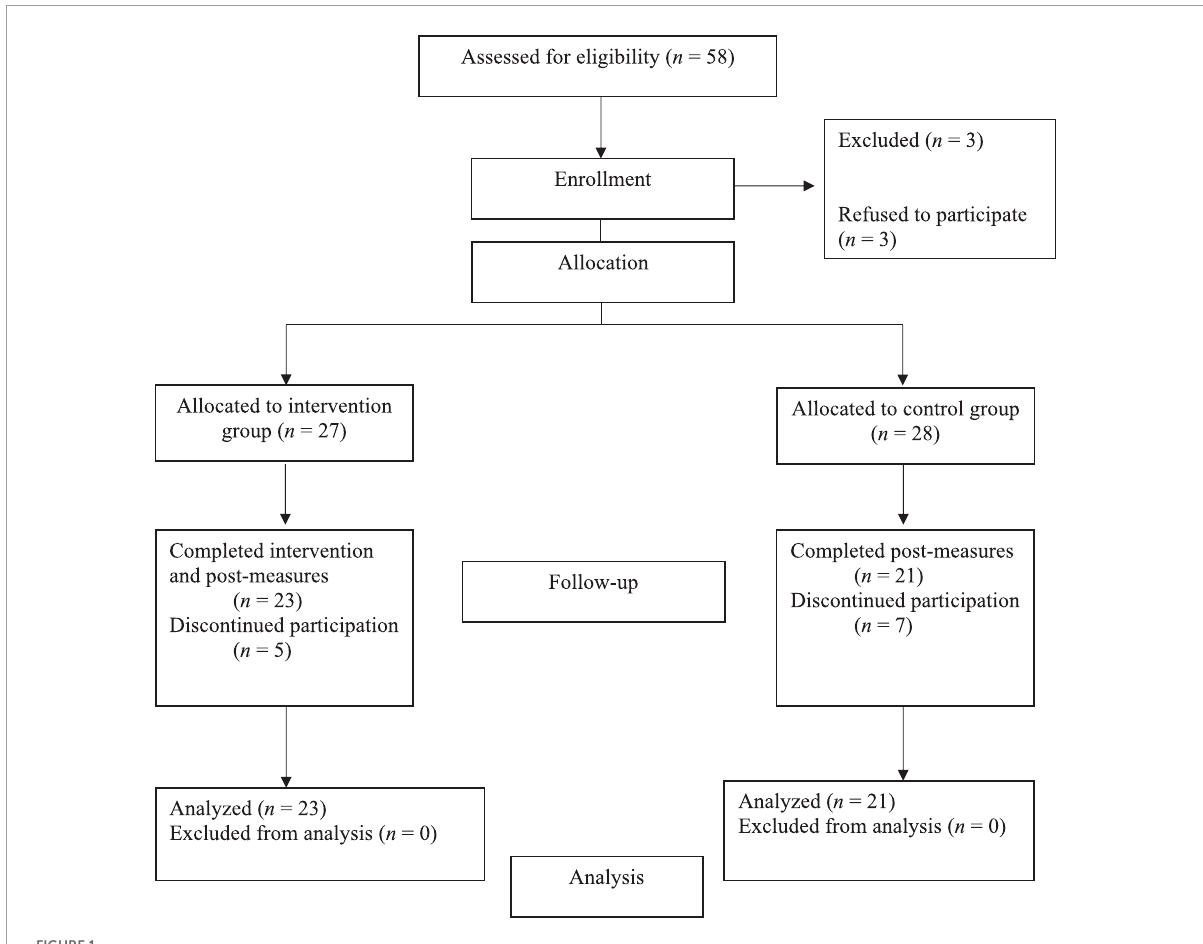
FIGURE1 Flowchart of participants through each stage of the